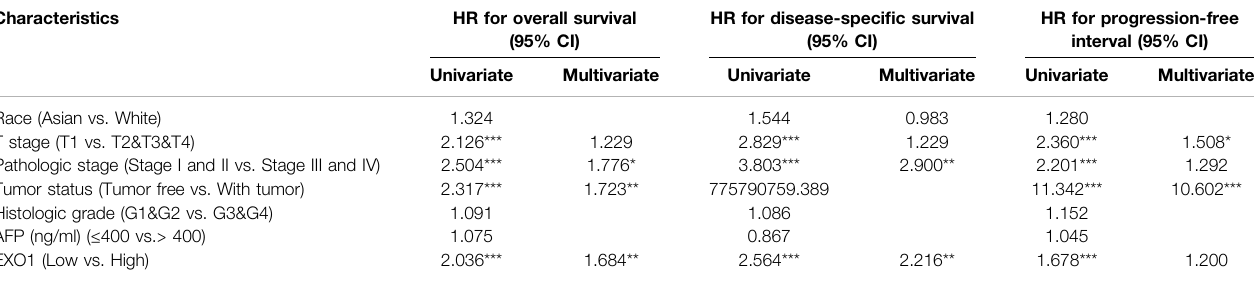
TABLE 4 | Cox regression analysis of the clinical outcomes in HCC patients based on various clinicopathological characteristics including EXO1 levels.